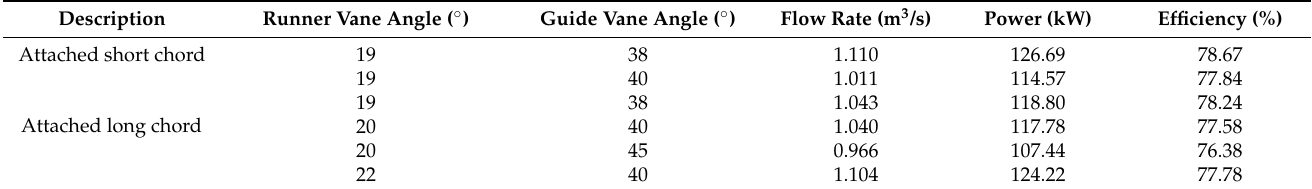
Table 10. Performance characteristics according to runner vane shape (H = 14.84